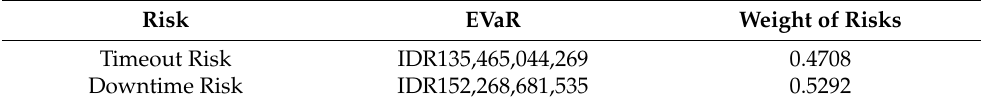
Table 6. The results of weighting risks using the portfolio